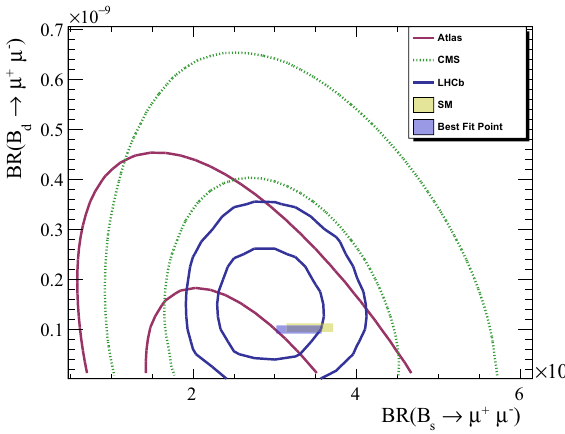
Fig. 5 Branching fractions for B s / B d → μ + μ − decays included in ourfit.Contourlinescorrespondtothejoint1and2 σ confidenceregions obtained in the measurements by ATLAS [87], CMS [86] and LHCb [85]. Yellow shading corresponds to Standard Model predictions and uncertainties, and blue shading shows the prediction and uncertainty of our best-fit model